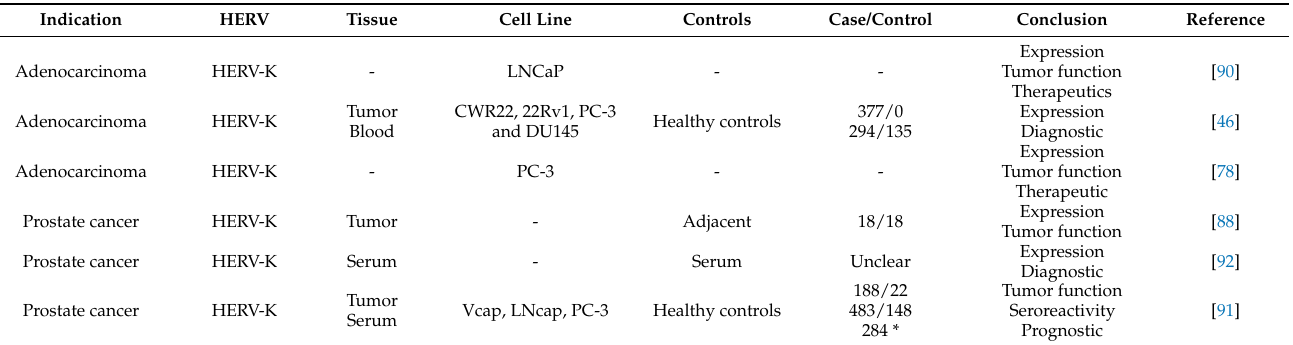
Table 5. HERV protein expression in prostate cancers.